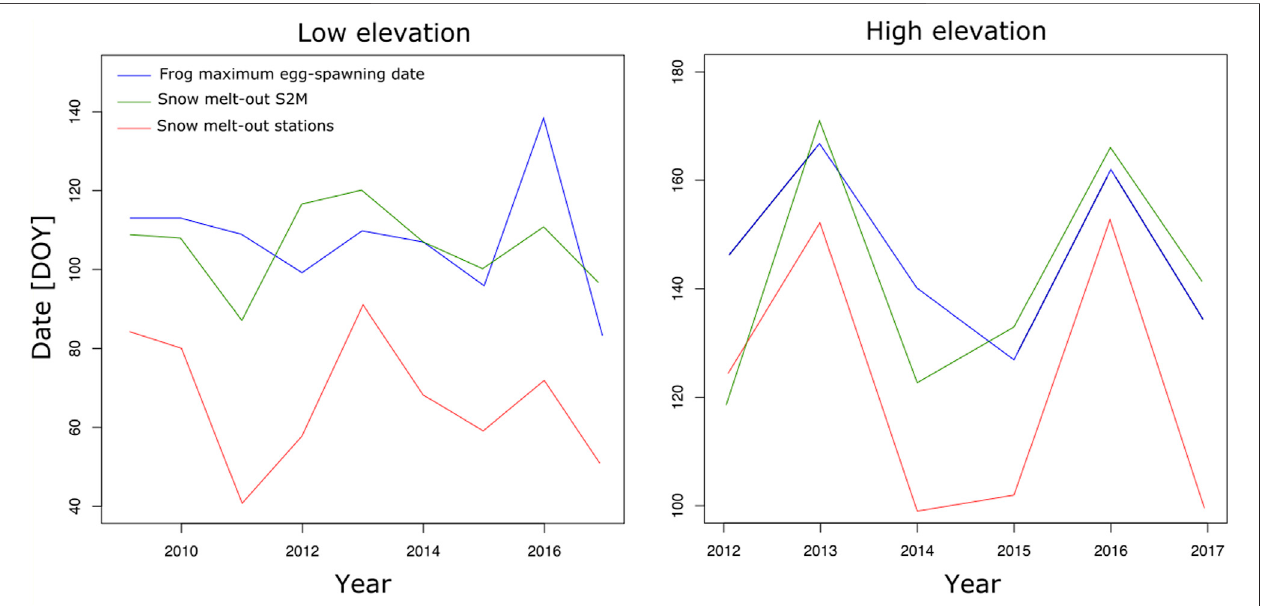
FIGURE 9 | Maximum frog egg-spawning date and snow melt-out date estimated from stations and S2M, in julian days, according to years, at low and high elevation.